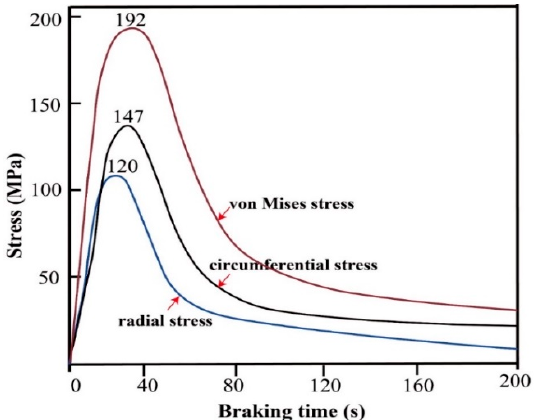
Figure 15. Stress in the circumference and radial direction versus time at different radii (IBV = 97 m/s, thickness of wear-resisting layer = 4 mm).